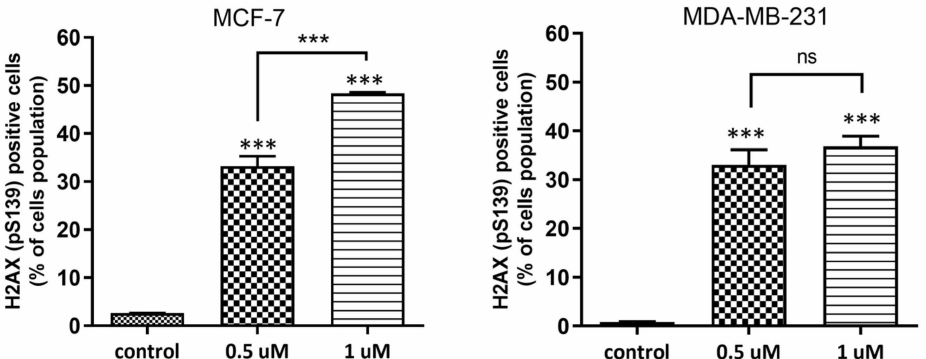
Figure 6. Induction of DNA damage by AJ-418 in MCF-7 and MDA-MB-231 cells. Cells were exposed to the tested compound at 0.5 µ M and 1 µ M concentration for 24 h, stained with anti-H2AX antibody (pS139) and analyzed using flow cytometry. Error bars represent means ± SEM of three independent experiments. *** p < 0.001 were considered statistically significant compared to controls, ns—no statistical